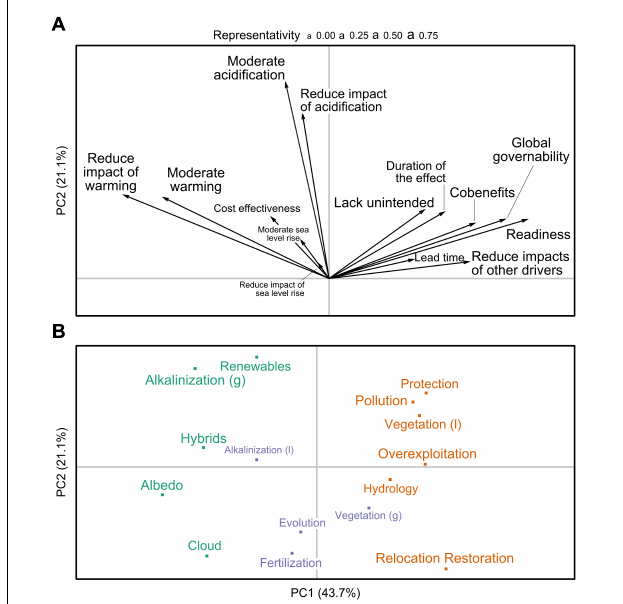
FIGURE 6 | Principal components analysis (PCA) of the attributes of ocean-based solutions. (A) Correlations among criteria, some being averaged across ecosystems and ecosystem services. When two arrows point in the same direction, the criteria are correlated: the scores of most solutions are similar for these two criteria (e.g., both warming-related criteria, co-benefits, and readiness). When they point in opposite directions, criteria are anti-correlated (e.g., moderate warming and global governability). When they are perpendicular, criteria are uncorrelated (e.g., acidification-related criteria and readiness). (B) Positions of solutions in the PCA. Solutions on the right have high scores in the criteria that point to the right and low scores in the attributes that point to the left; a similar reasoning can be made for any direction in this space. Solutions are clustered into three groups, through hierarchical clustering based on their position in the PCA space, and colored accordingly. The first two principal components explain 65% of the variance in the attributes of ocean-based solutions. Attributes or solutions that are not well represented in this space are shown in smaller font (representativity or “Repr.” varies between 0 and 1). See section “SM5” of the Supplementary Materials for details on the PCA approach, and sections “SM3 and SM4” for additional information on the